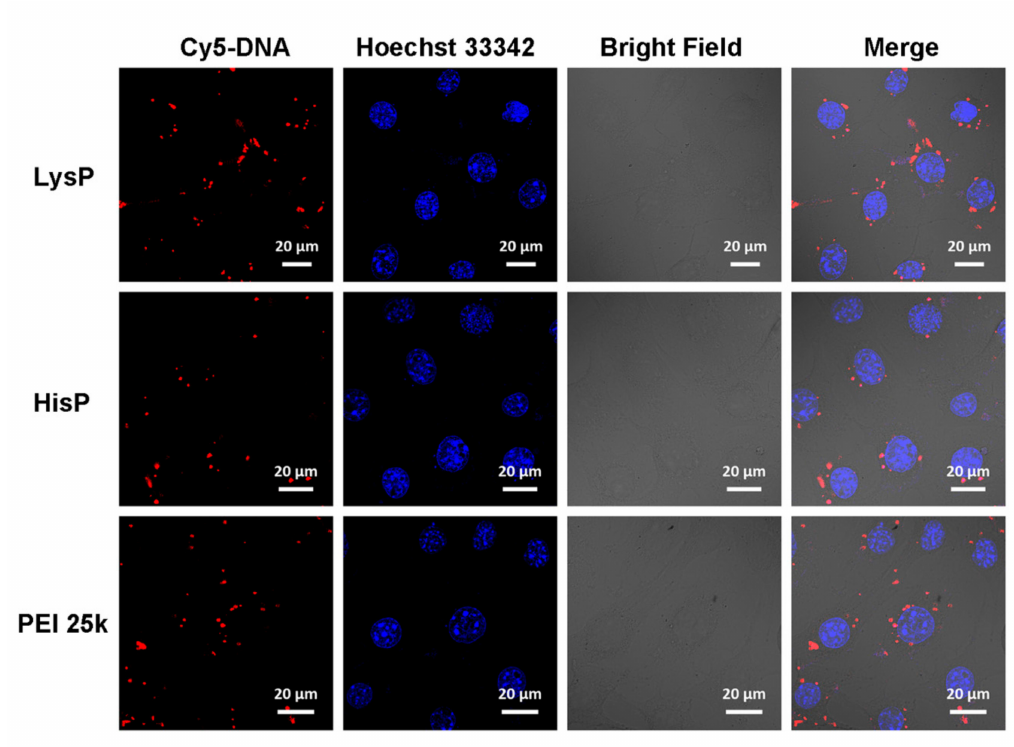
Figure 8. CLSM images of B16 cells transfected with Cy5-labaled DNA by polymers at optimal weight ratio. PEI 25 kDa ( w / w = 1.4) was used as